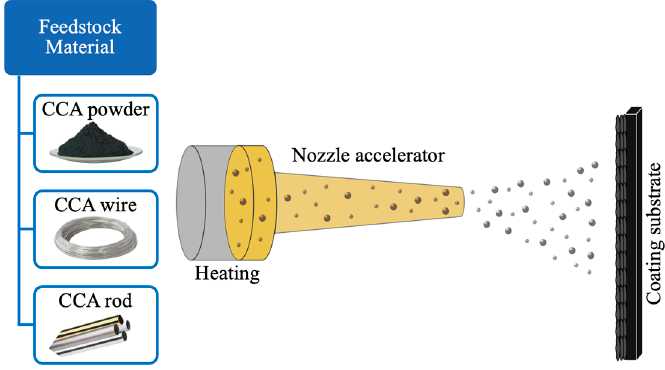
Figure 1. Schematic diagram showing the thermal spray process.